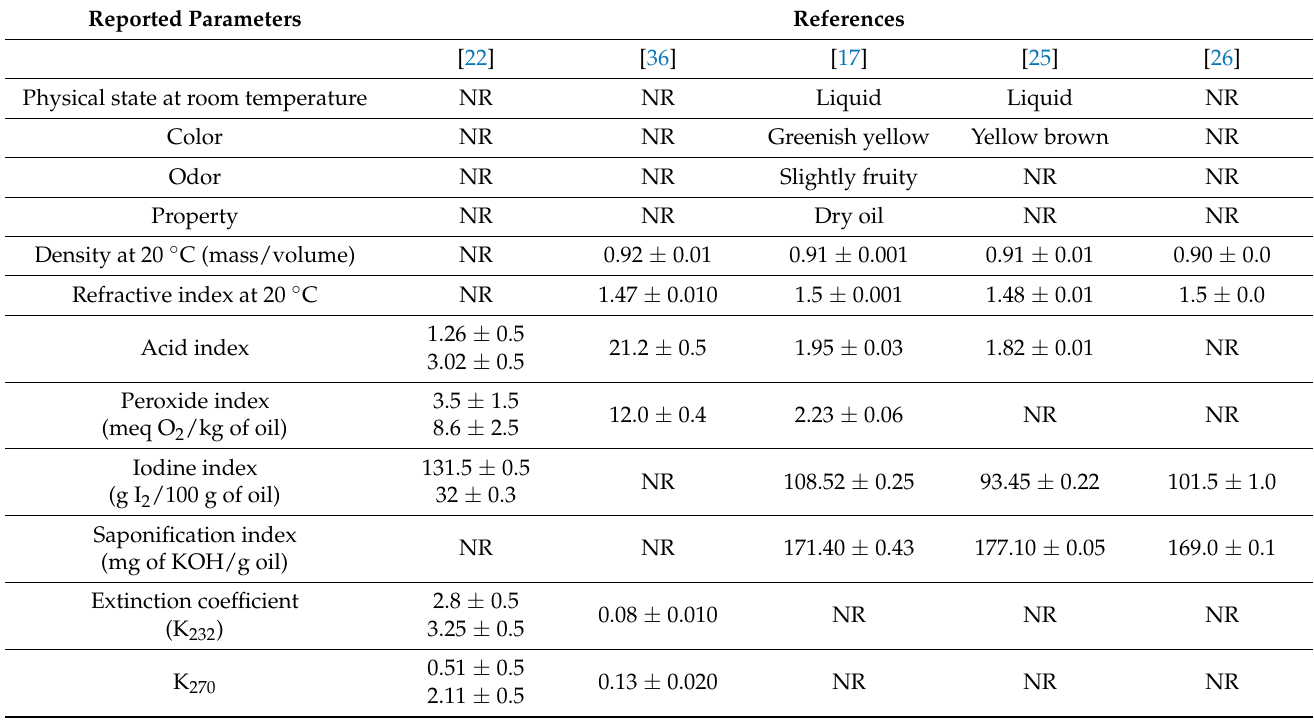
Table 2. Physicochemical characteristics of prickly pear seed